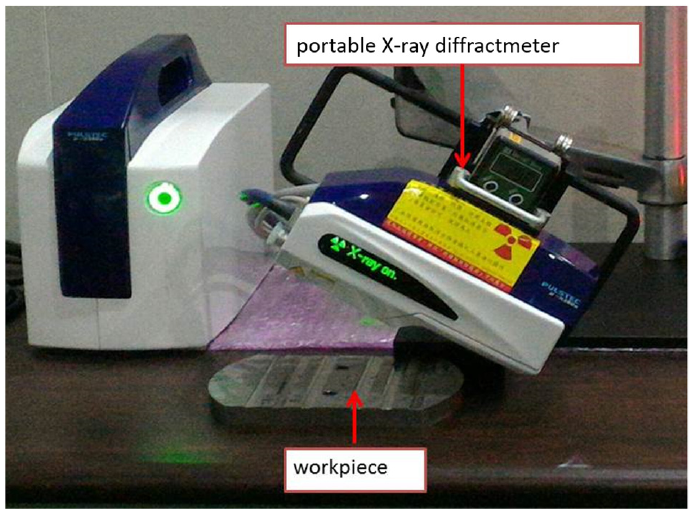
Figure 5. Portable X-ray diffractometer .